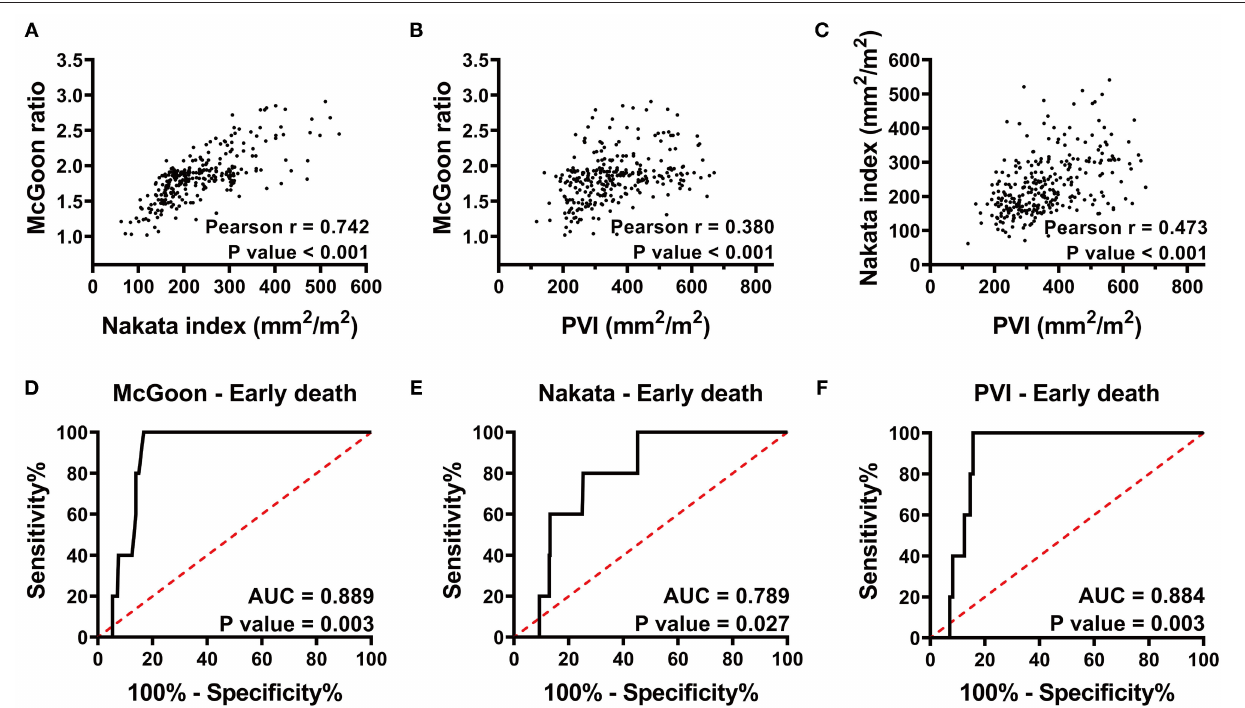
FIGURE 1 | (A–C) Pearson correlation analysis of the McGoon ratio, Nakata index, and PVI indicate that the McGoon ratio has a strong correlation with the Nakata index, whereas, the correlation between the PVI and the two PA parameters was weak. (D–F) Receiver operating characteristic curve analysis indicates the predictive value of the McGoon ratio, Nakata index, and PVI for early death. PVI has a predictive value similar to that of the McGoon ratio and much better than that of the Nakata index. r, Pearson correlation coefficient; AUC, area under the ROC curve; PVI, pulmonary vein index. p < 0.05 indicates statistical significance.